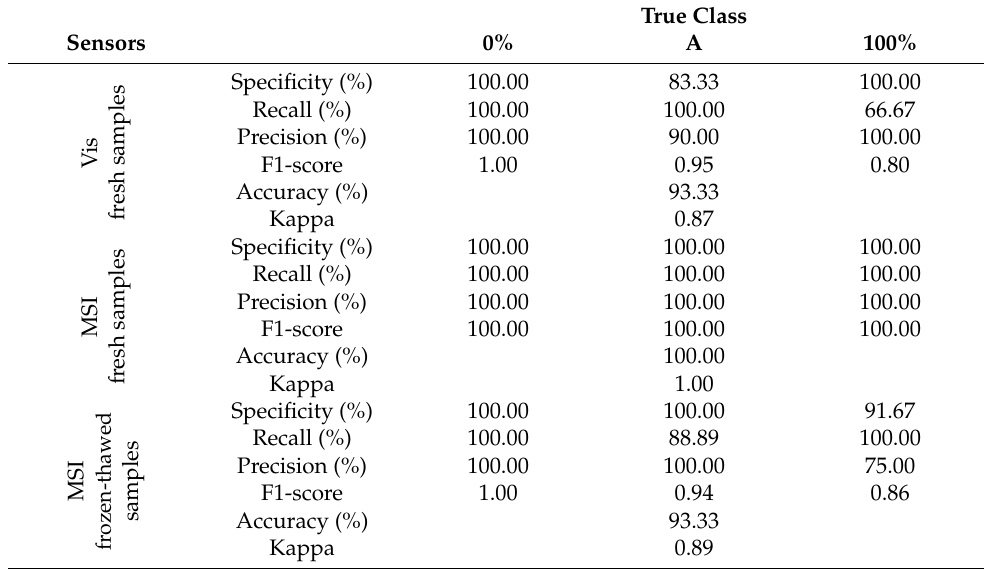
Table 2. Specificity, recall, precision, F1-score, accuracy and kappa for the classification of SVMs for the external validation ( n = 30) of fresh samples using Vis and MSI data and of frozen-thawed samples using MSI data considering three classes: 0% pork-100% chicken (0%); adulterated (A); 100% pork-0% chicken (100%).